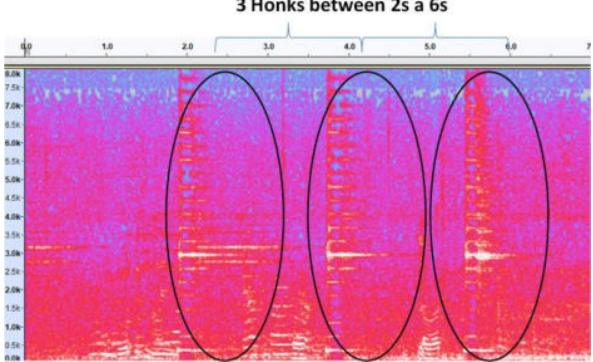
Figure 4. Honks Spectrogram.